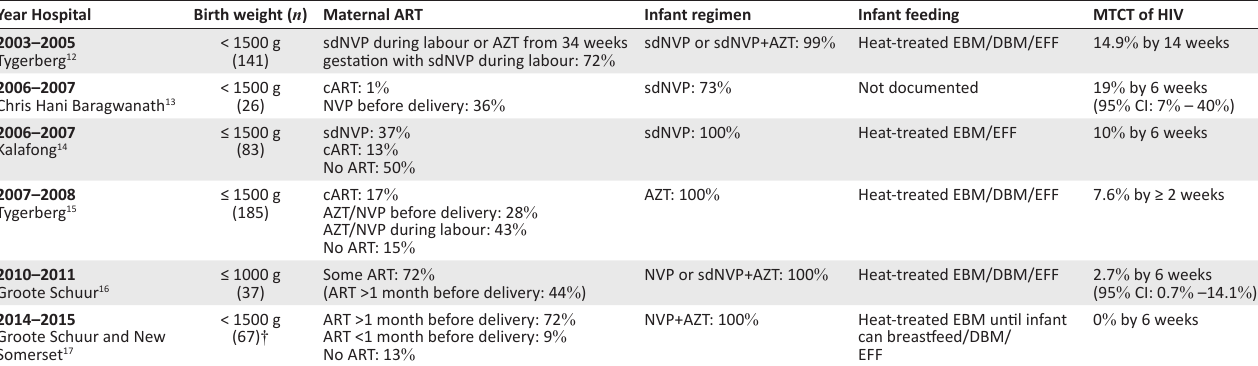
TABLE 1: South African studies reporting on human immunodeficiency virus transmission by postnatal age in infants ≤ 1500 g birth weight. Year Hospital Birth weight ( n ) Maternal